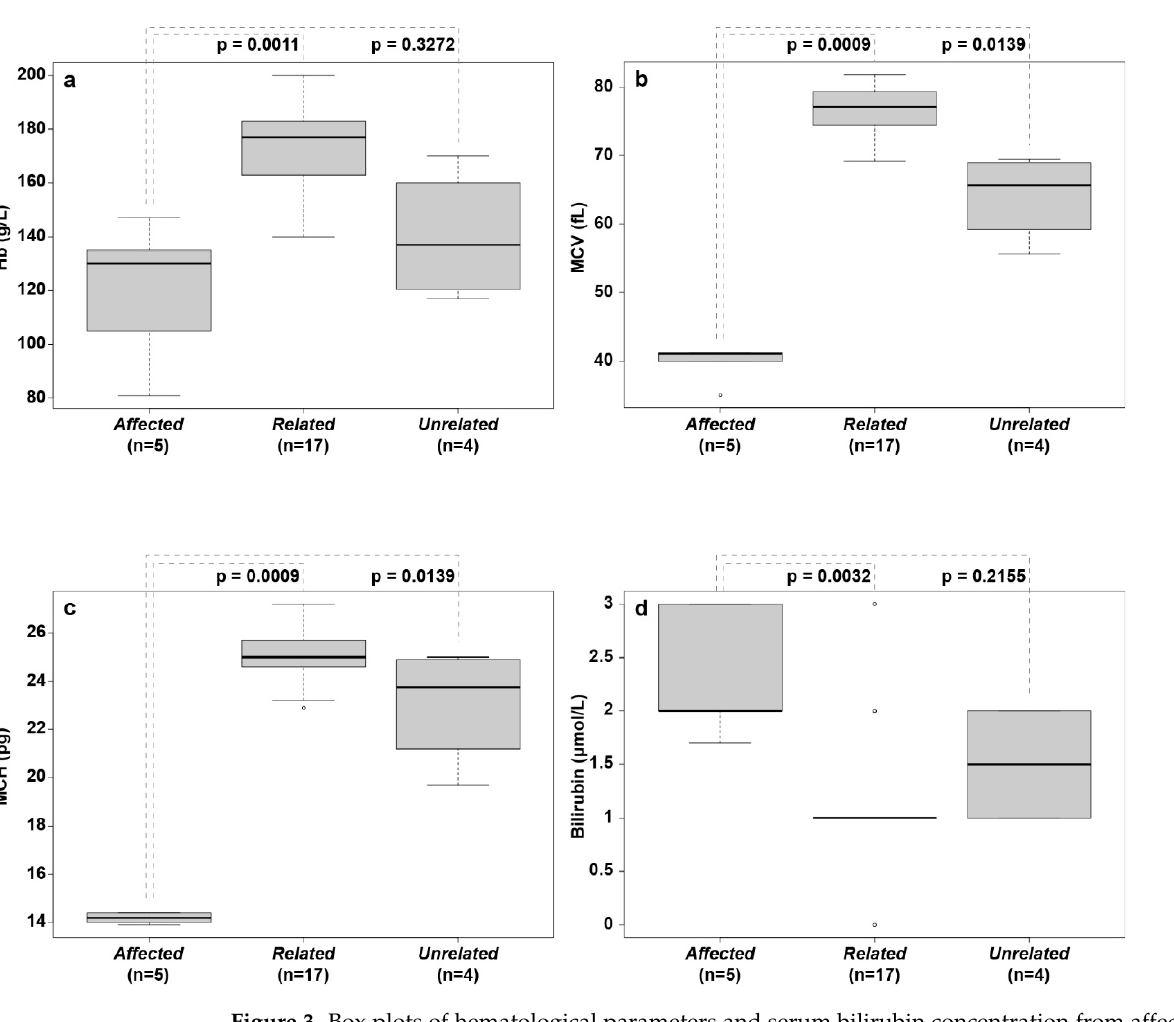
Figure 3. Box plots of hematological parameters and serum bilirubin concentration from affected, related, and unrelated English springer spaniels. ( a ) Hemoglobin concentration (Hb/g/L); ( b ) mean corpuscular volume (MCV/fL); ( c ) mean cell hemoglobin (MCH/pg; ( d ) bilirubin concentration ( µ mol/L). The median values are indicated by horizontal lines in the boxes, where the first to third quartiles define the boundaries. Whiskers extend to the minimum and maximum values. The affected dogs had significantly lower MCV and MCH values than those of both other groups, and they had lower Hb than that of related healthy